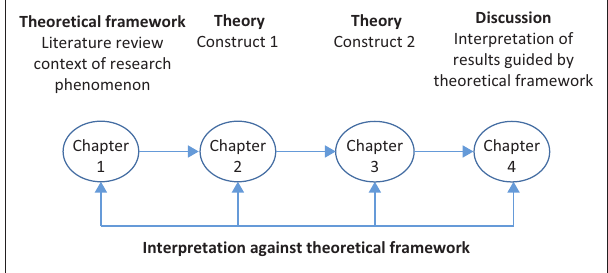
FIGURE 4: Theory in qualitative research designs (deductive).